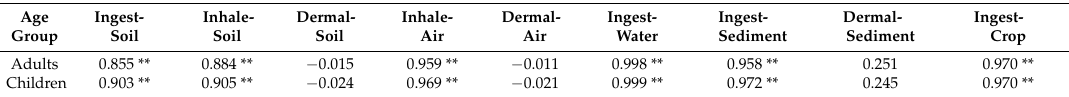
Table 5. Correlation coefficients between the concentrations of trace metals in hair and average daily dose of trace metals via different pathways.